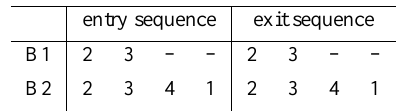
Table 1. Entry and exit sequence of spacecraft for features B1 and B2 in Figs. 6 and